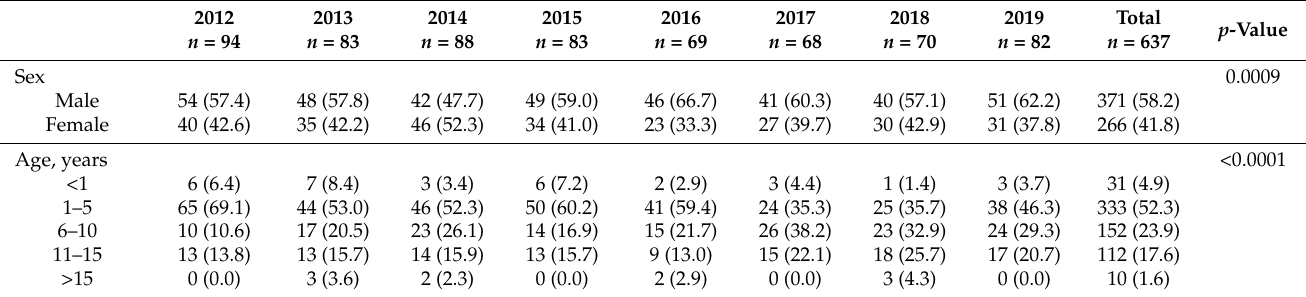
Table 2. Sex, age, fever at the onset, and IPV distribution among AFP patients in Korea surveillance, 2012–2019. 2012 n =